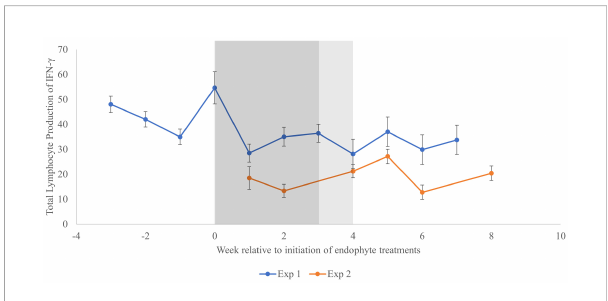
FIGURE 2 Change in total in vitro lymphocyte production of interferon-